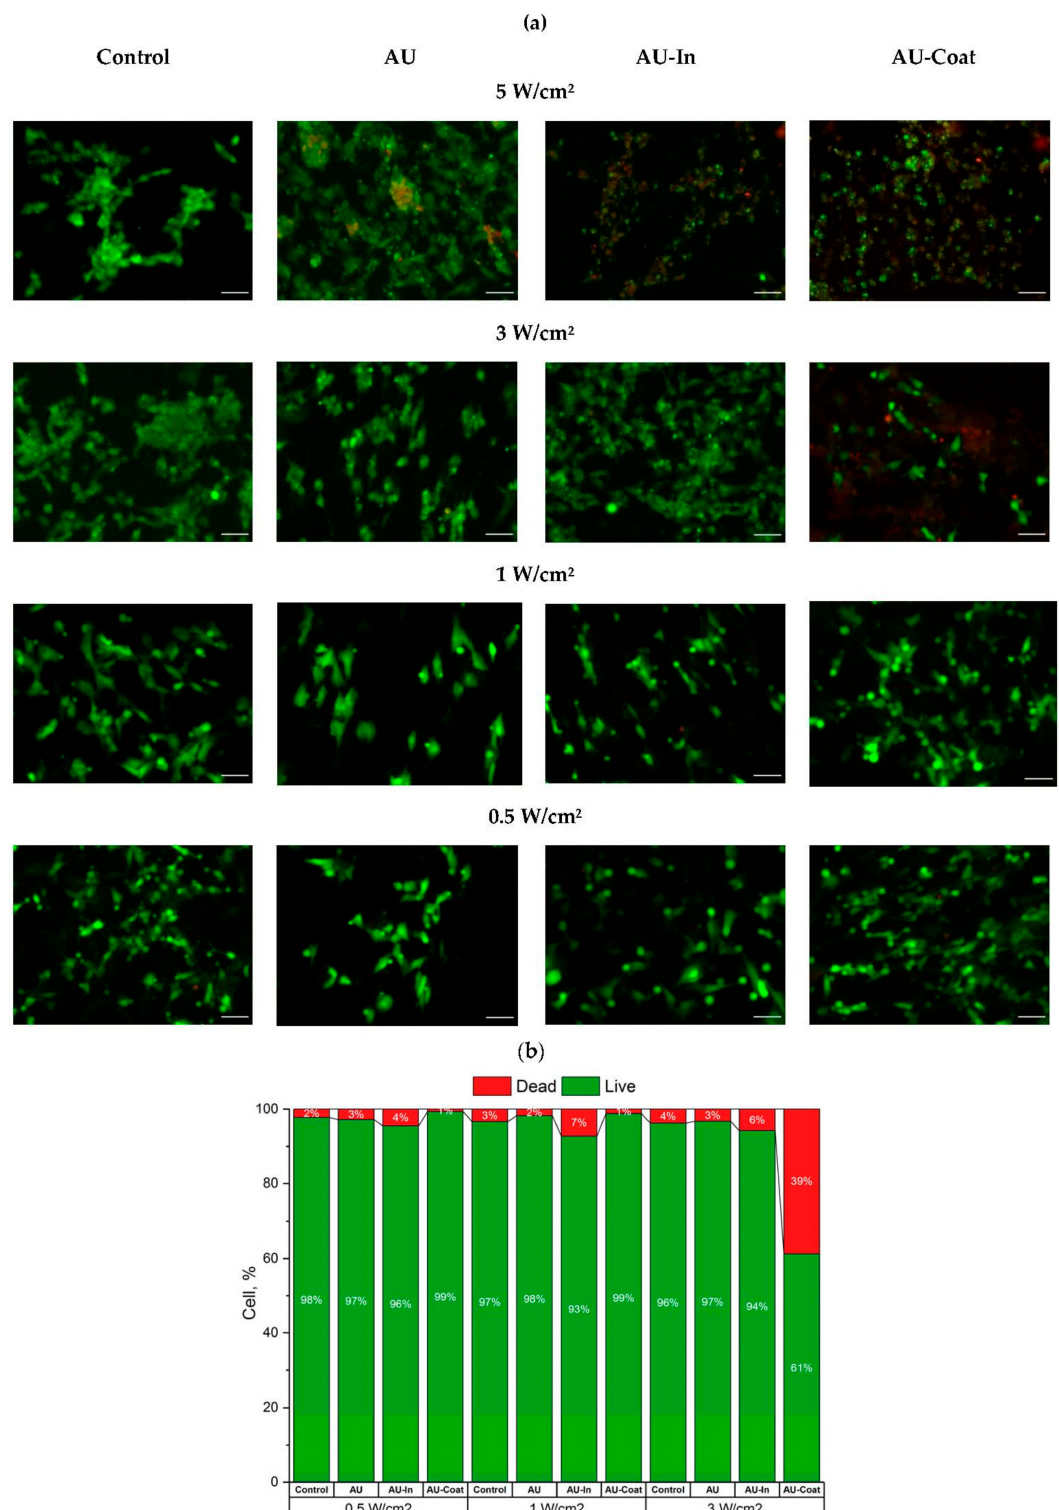
Figure 4. Cell viability of differentiated SH-SY5Y cells grown on AU and thermo-plasmonic nanofibers and exposed to NIR irradiation at different power density (0.5, 1, 3, and 5 W/cm 2 for 5 min). Representative fluorescence images of the LIVE/DEAD analysis for 24 h after NIR exposition ( a ). Green—live cells stained with calcein AM, red—dead cells stained with propidium iodide. Scale bar—50 µ m. Bars show relative fractions of live and dead cells as an average of three independent experiments ( b